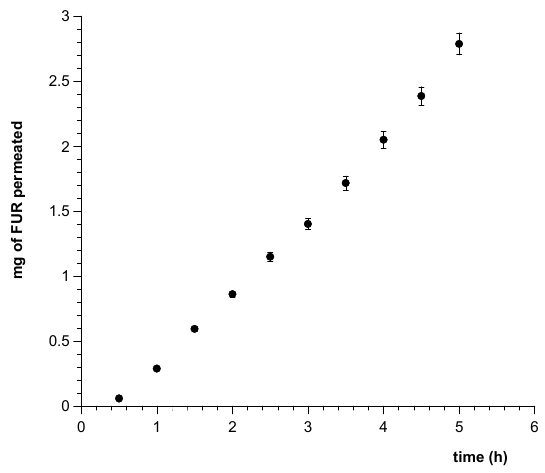
Figure 7. Plot of cumulative amount of FUR permeated across porcine sublingual mucosa vs. time from a patch (0.5 cm 2 ) soaked with simulated saliva. Values are presented as means ± SD ( n = 12).